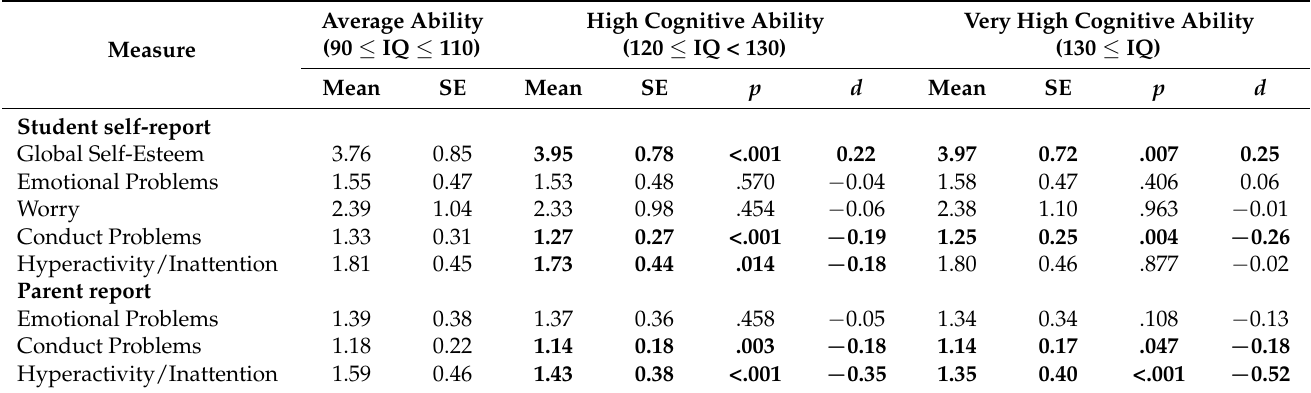
Table 2. Comparison of mental health indicators in adolescents with high and very high cognitive ability vs. adolescents with average cognitive ability.